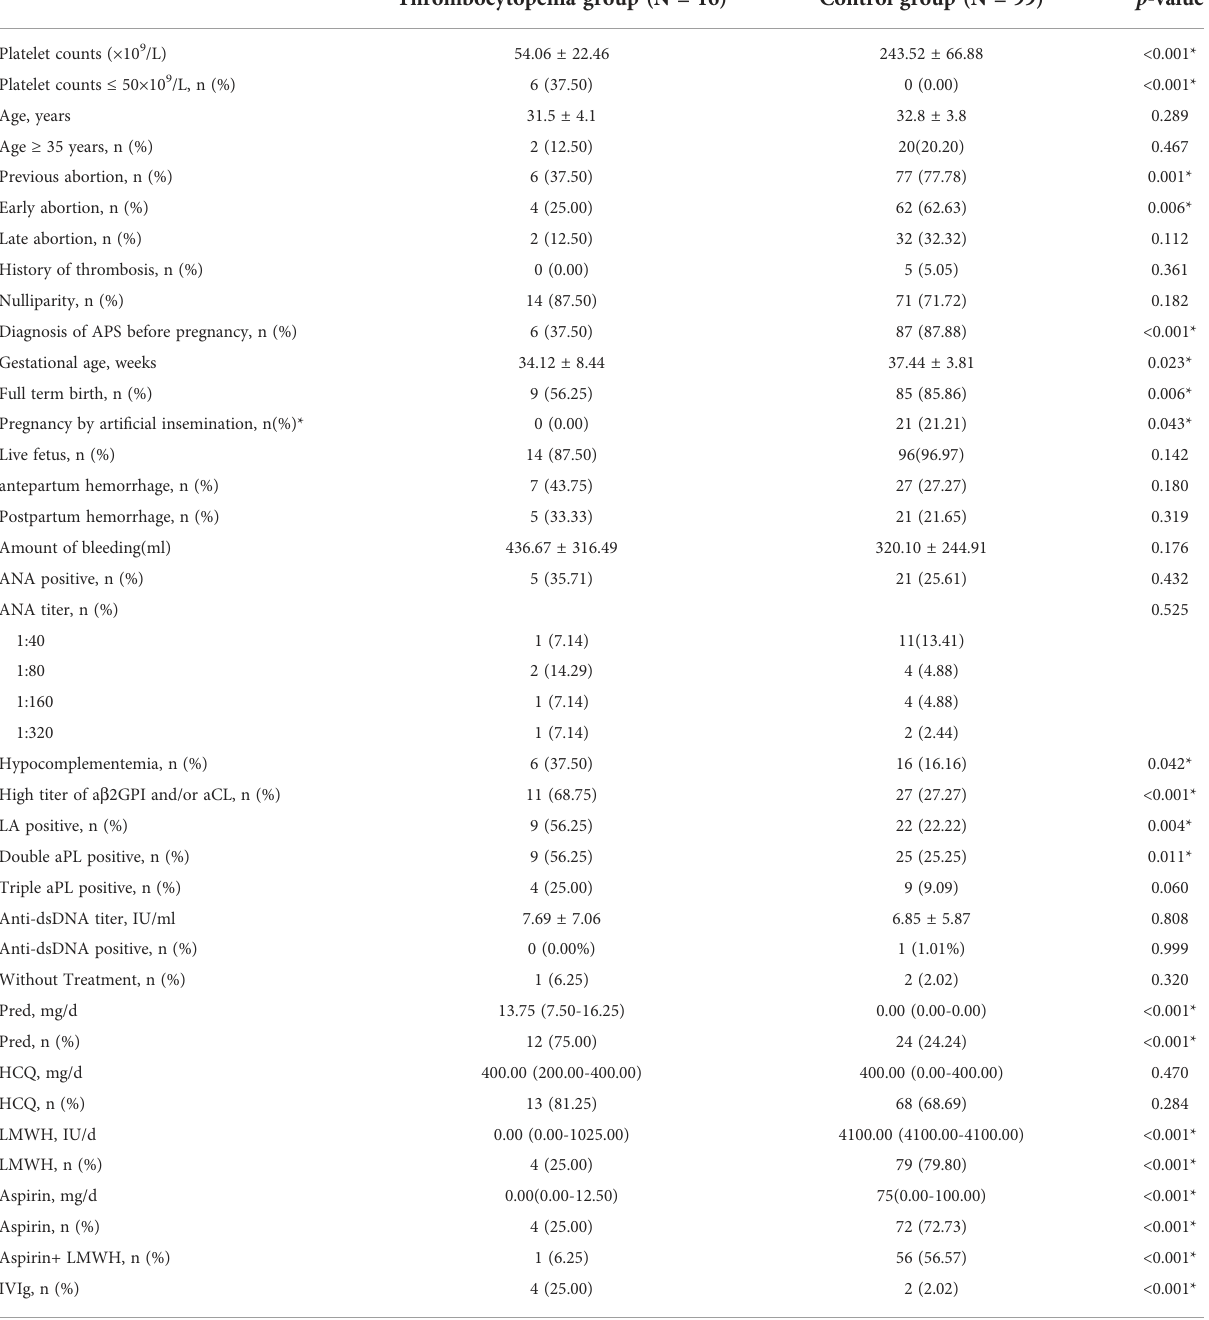
TABLE 1 Basic and gestational characteristics between the two groups. Thrombocytopenia group (N =